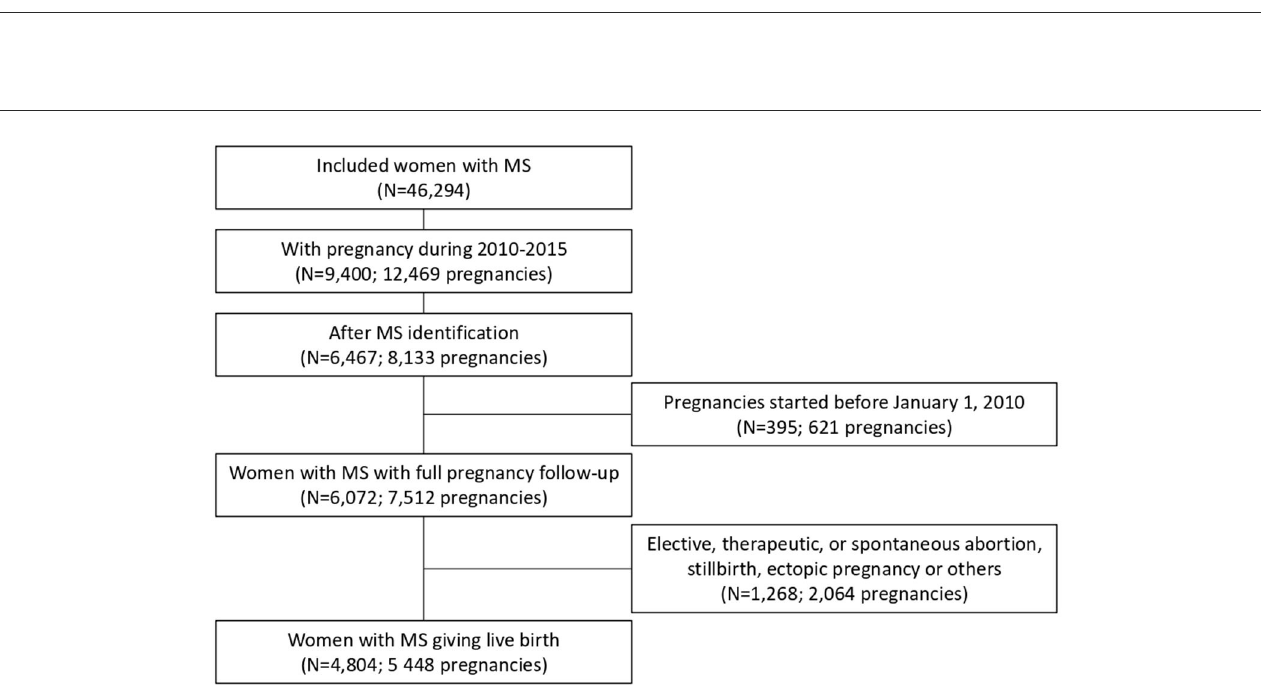
FIGURE2 Flowchart of the sample selection: 4,804 women with MS in France from 2010 to